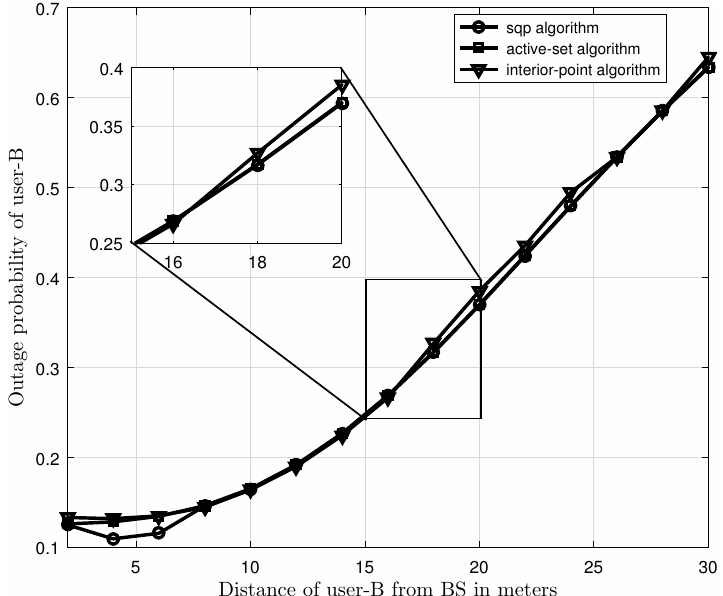
Figure 4. Outage probability comparison of “sqp”, “active-set”, and “interior-point” algorithms for specification of experiment.